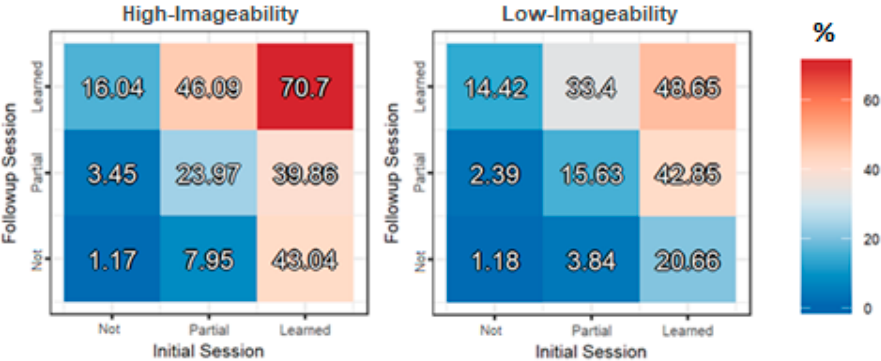
Figure 4. Surprise recall test accuracy (%) based on learning in the initial (first) and follow-up (second) training sessions divided by word imageability, with the high-imageability words on the left and the low-imageability words on the right.